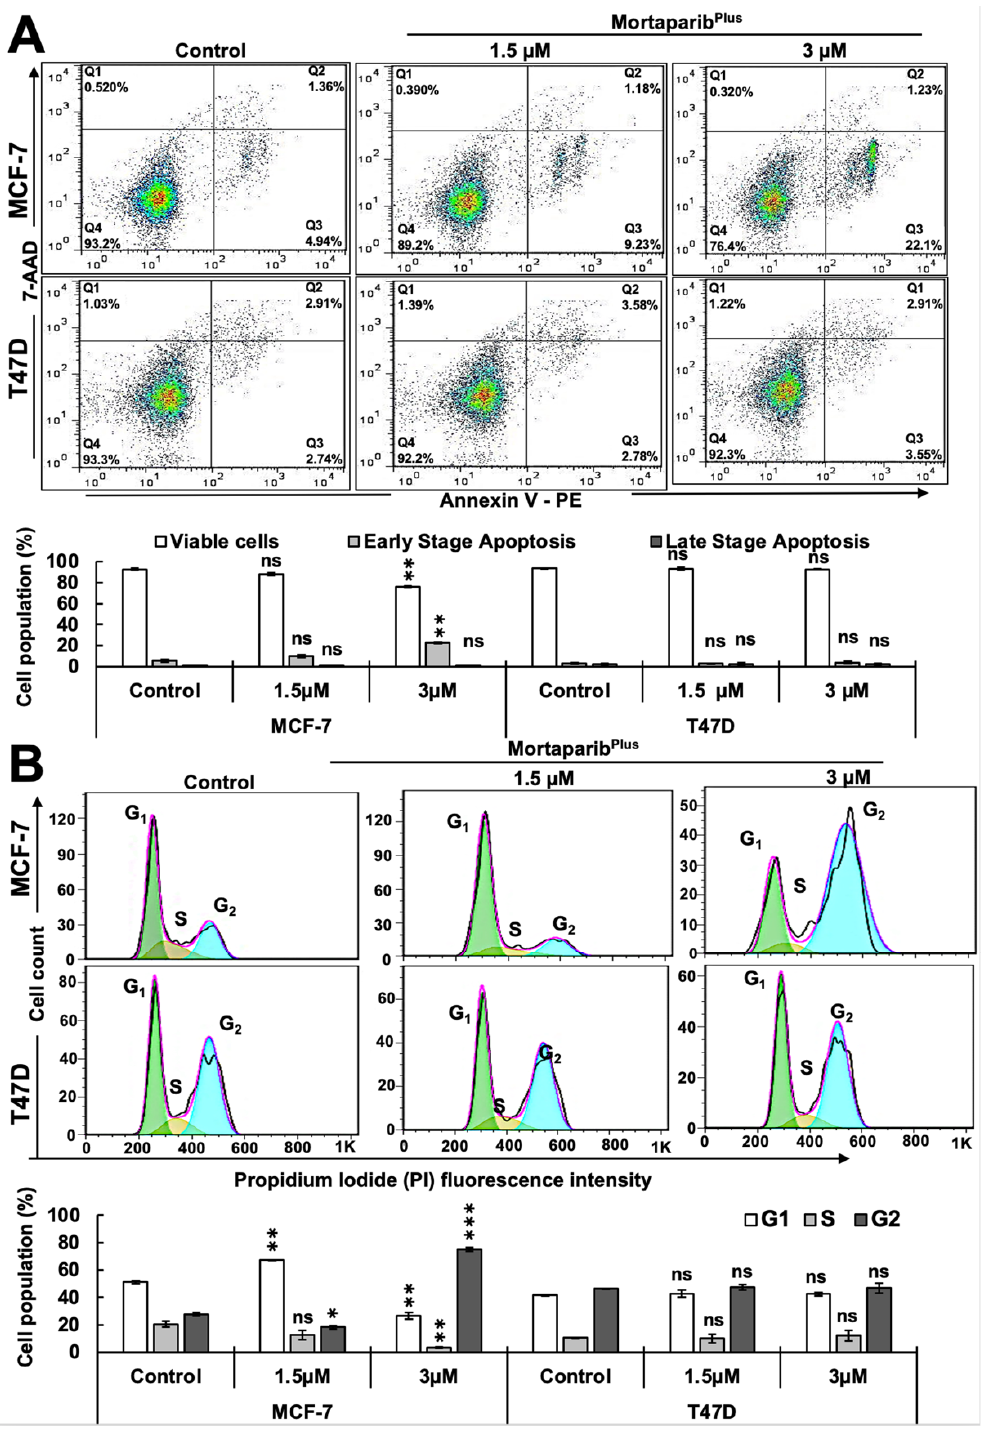
Figure 4. Mortaparib Plus induced apoptosis and G 2 /M cell cycle arrest only in the wild type p53- harboring Luminal-A breast cancer cells. Flow cytometric analyses for control and 48 h Mortaparib Plus -treated cells showed an increase in the early apoptotic cell populations in Mortaparib Plus -treated MCF-7, but not T47D, cells ( A ). Using the same flow cytometric platform, cell cycle progression analyses for control and 48 h-Mortaparib Plus -treated cells revealed that Mortaparib Plus (3 μ M) induced a strong G 2 /M cell cycle arrest in MCF-7 cells; Mortaparib Plus -treated T47D cells were not arrested at either G 1 /S or G 2 /M cell cycle phases ( B ). The quantified data represent mean ± SD obtained from independent biological replicates; p -values were calculated using unpaired Student’s t -test. ns > 0.05, * ≤ 0.05, ** ≤ 0.01, and *** ≤ 0.001 represent non-significant, significant, very significant, and highly significant, respectively.